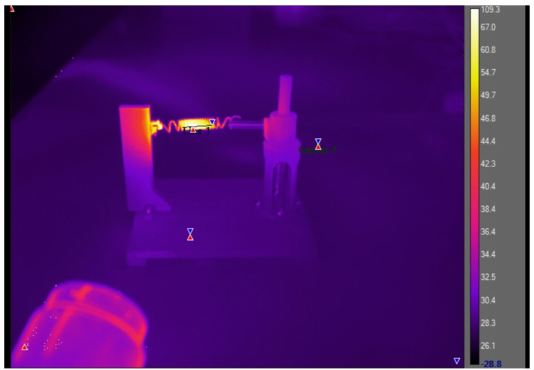
Figure 12. Thermogram of the actuator set up during the SMA